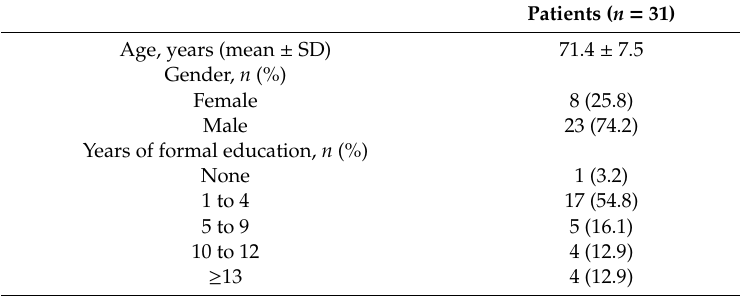
Table 1. Characteristics of participants with chronic obstructive pulmonary disease ( n =